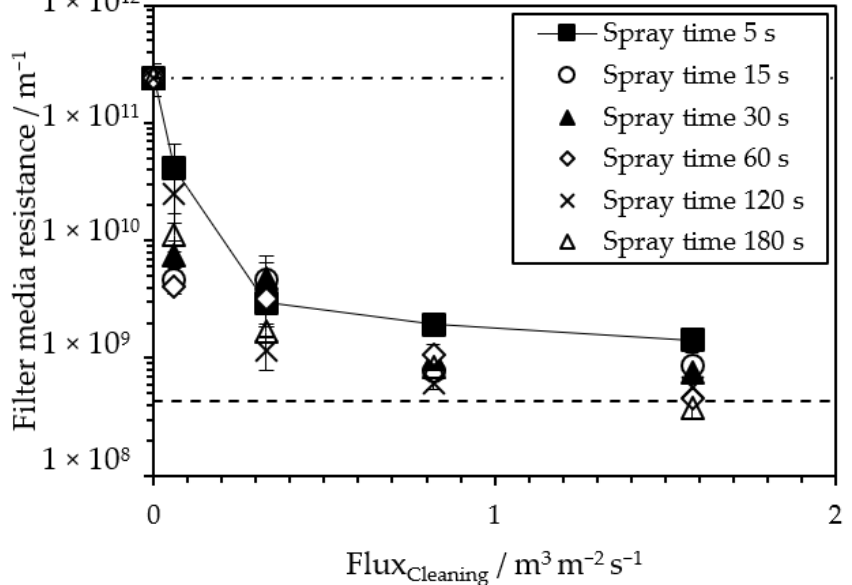
Figure 5. Filter media flow resistance after back-wash cleaning for the different spray times over flux. Blinded (after 1000 filtration cycles) and unused state are depicted as a reference with a dot-dashed and a dashed line.